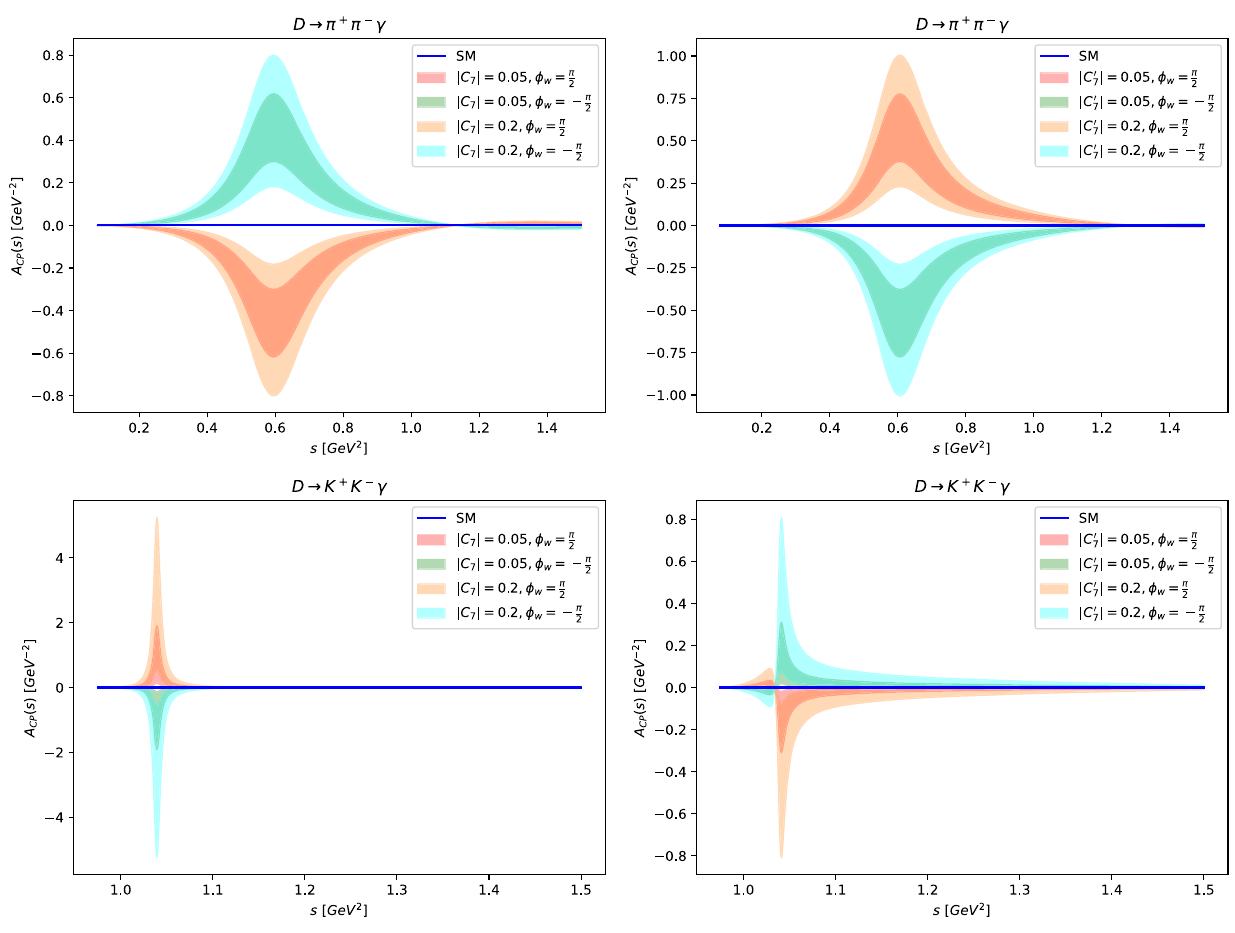
( (cid:7) ) to 0 and the other one to 0 . 05 , 0 . 2. The weak phase one coefficient C 7 ( (cid:7) ) of C is φ w = ± π/ 2. We performed a cut s ≤ 1 . 5GeV 2 to remain 7 within the region where QCDF